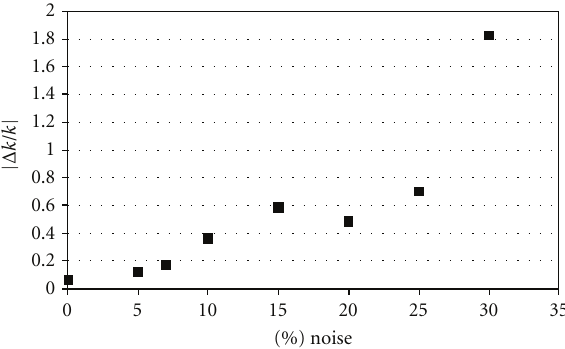
Figure 13: Absolute relative error in the calculation of the reflection coe ffi cient against noise